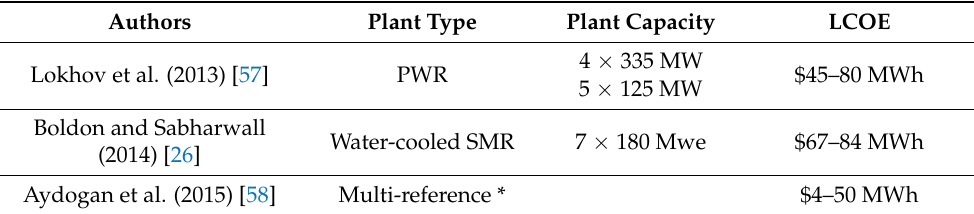
Table 5. LCOE estimate of various